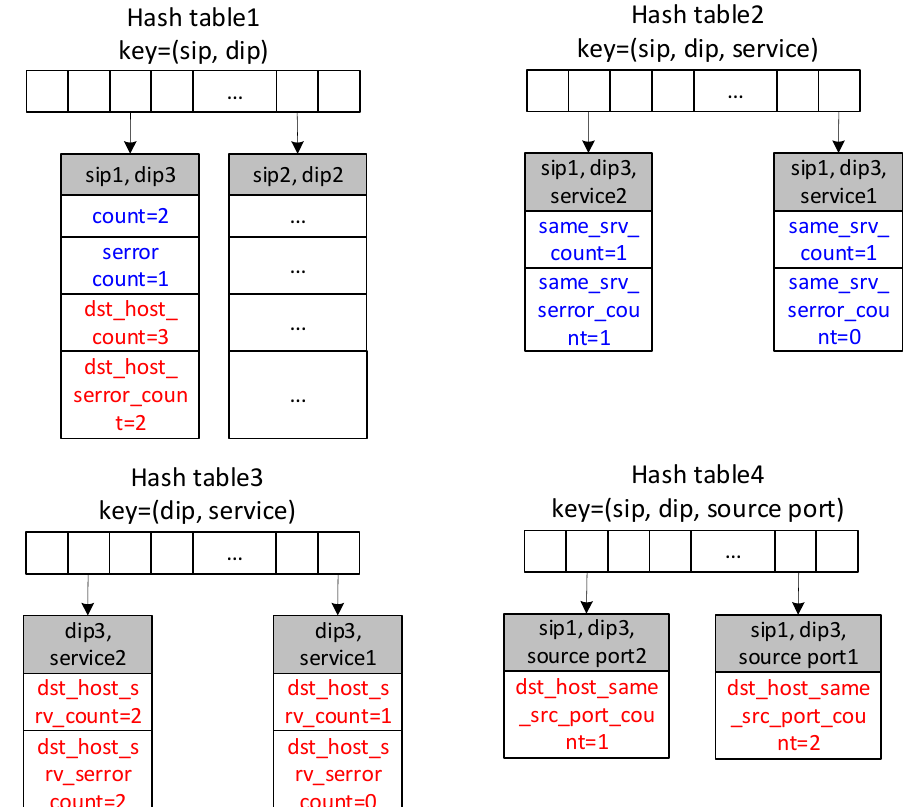
Figure 5. Four hashes to maintain statistics needed to generate multi-host session features in real-time. The blue and red colors represent values associated with sessions stored in the linear queue and the circular queue, respectively.